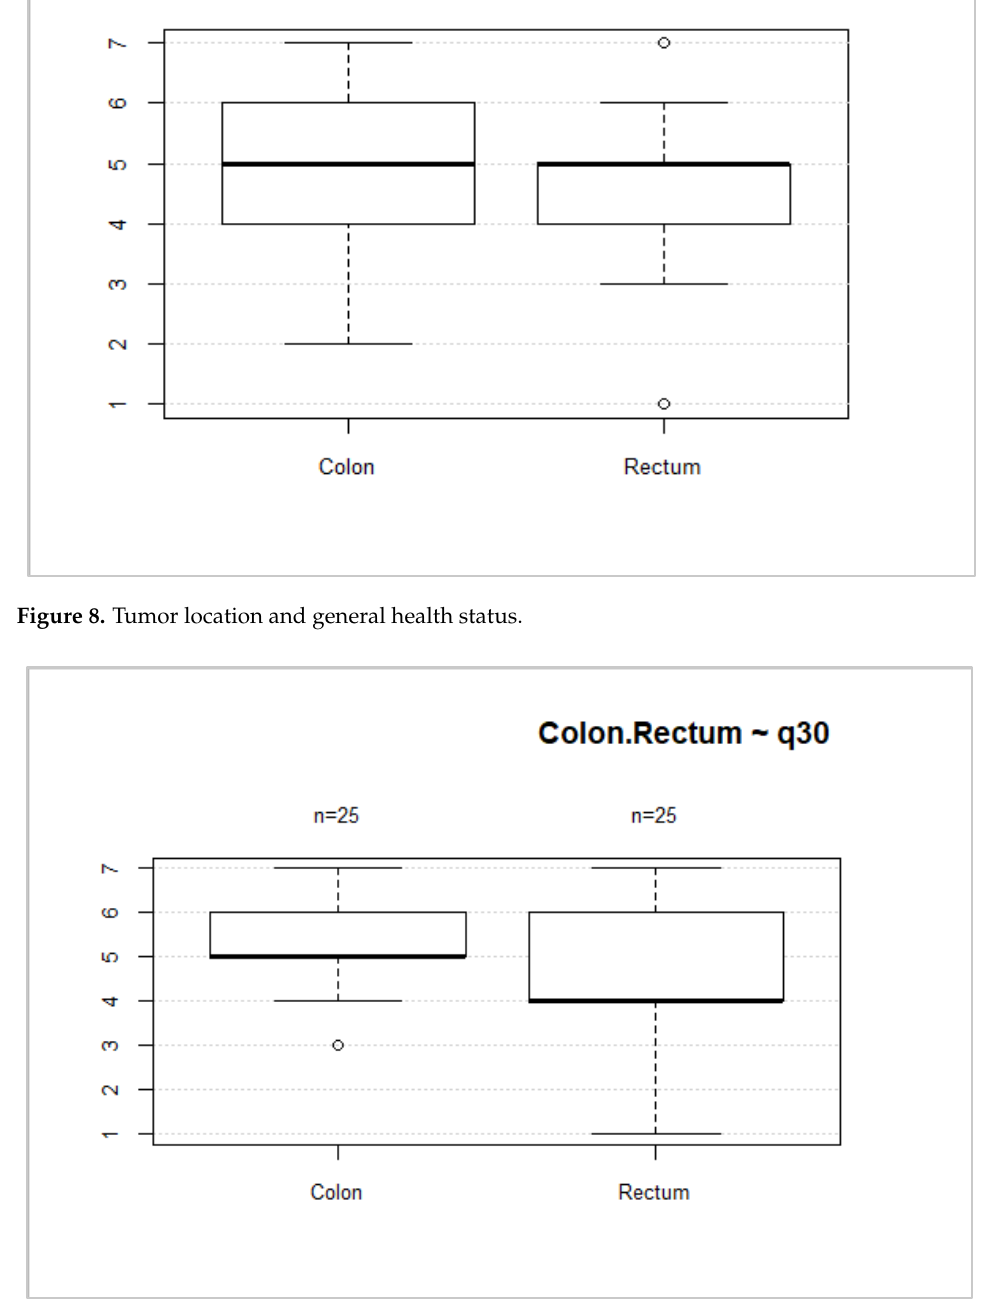
Table 2. Multivariate analysis of factors predicting poorer quality of life.